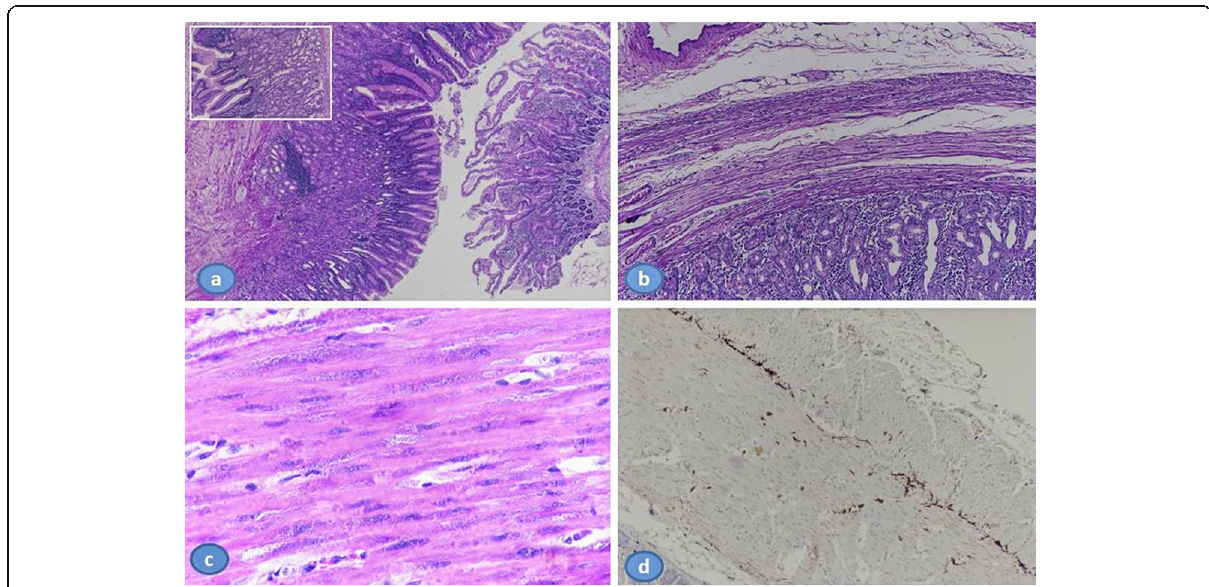
Fig. 2 Structural changes. A Showing heterotopic gastric mucosa containing fundic type of gland (inset — showing pyloric gland). B Disorganization & atrophy of muscularis propria with focal duplication of inner circular layer. C Cytoplasmic granular degeneration of smooth muscle fibers. D Normal preservation of interstitial cell of cajal highlighted by CD117